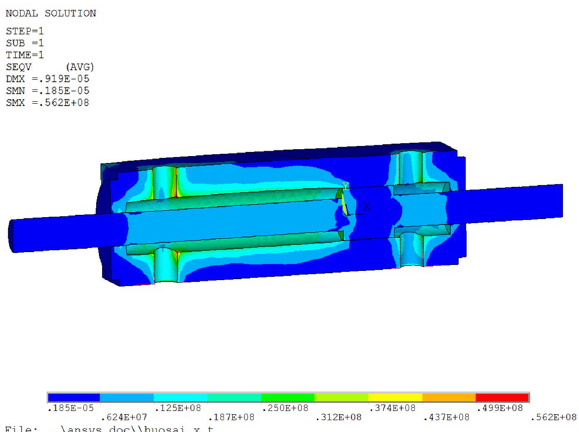
Fig. 9 Equivalent stress of the piston cylinder